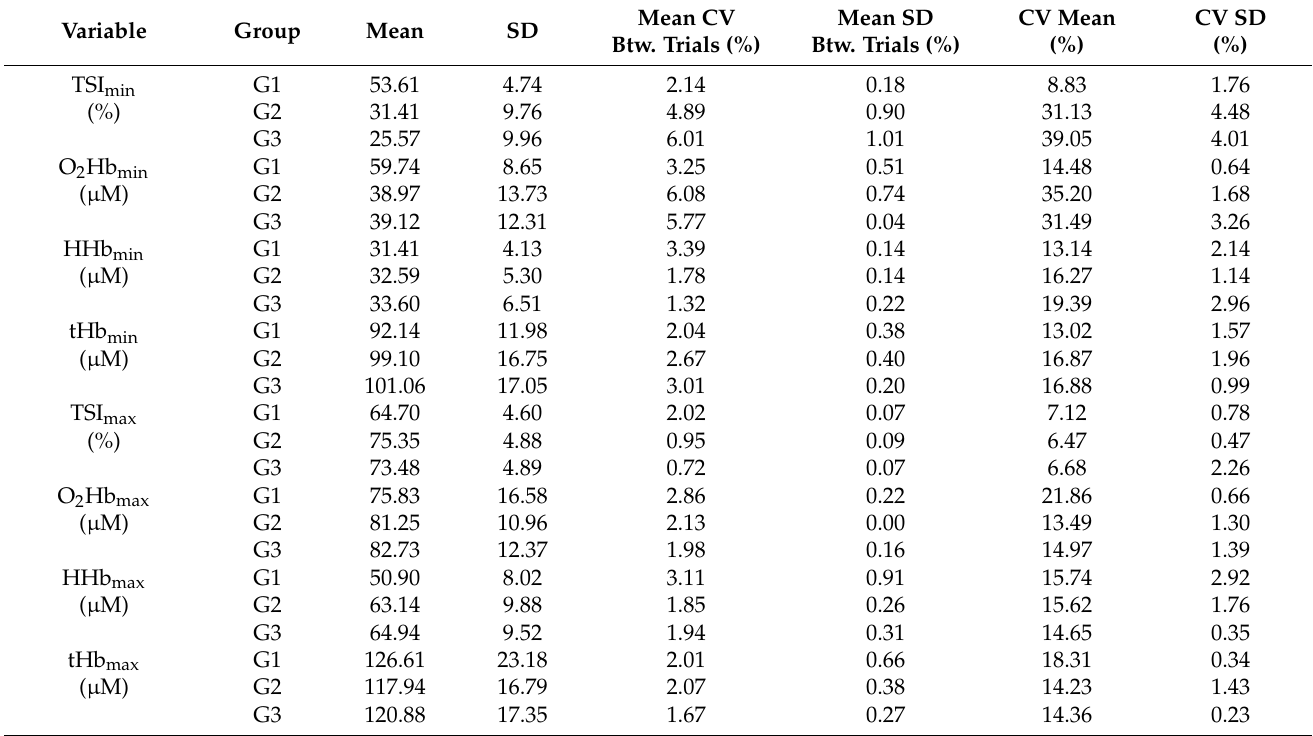
Table 3. Maximum and minimum variability.